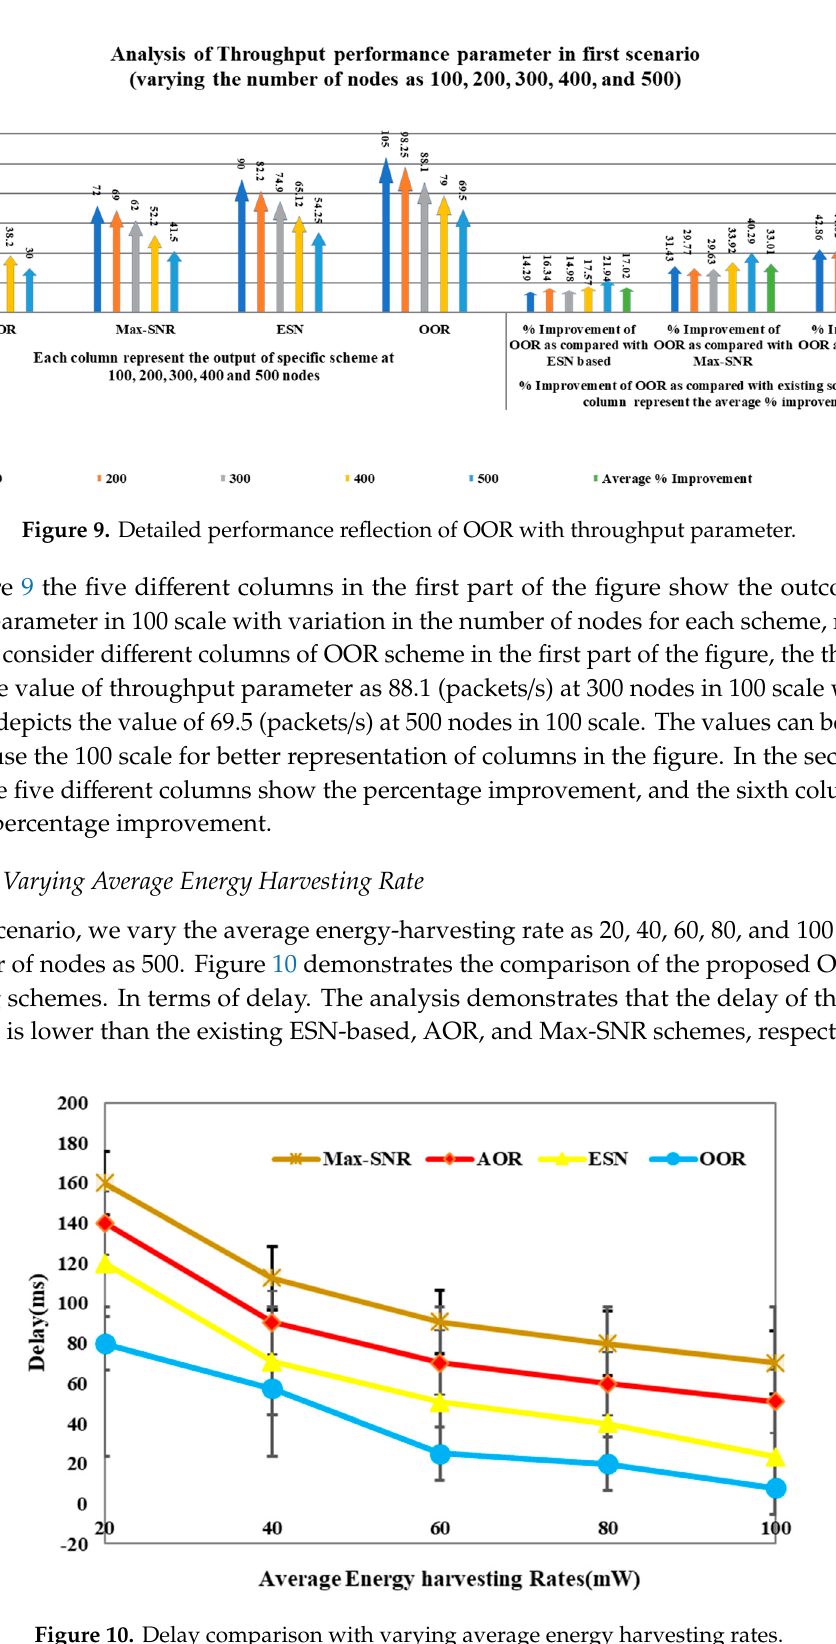
14 of 21 Figure 8. Throughput comparison with varying number of nodes. Table 3. Descriptive observations of OOR performance in terms of throughput. Throughput(packets/s) Comparison with Varying Number of Nodes